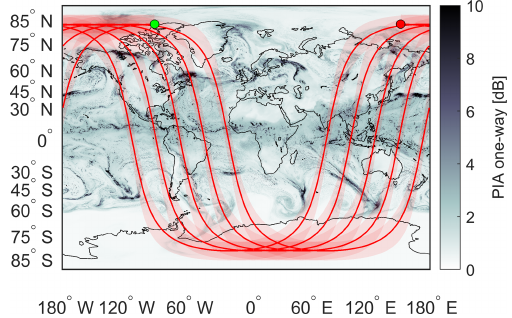
Figure 3. Example of a simulation of five WIVERN orbits with the ground tracks (red lines) and the 800km WIVERN scanning swath (red-shaded region) plotted over the hydrometeor one-way path integrated W-band attenuation (the color bar scale is in dB). A single model snapshot is used for the